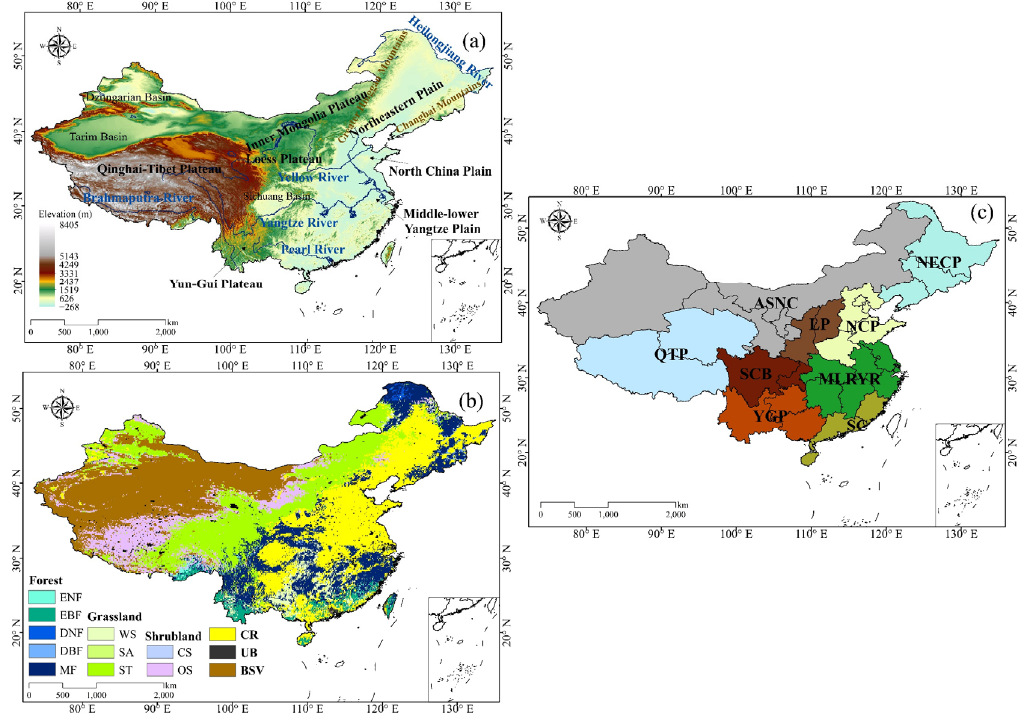
Figure 1. ( a ) Topographic and geographic zones of China; ( b ) land-cover types of China; and ( c ) the nine major crop production areas of China.